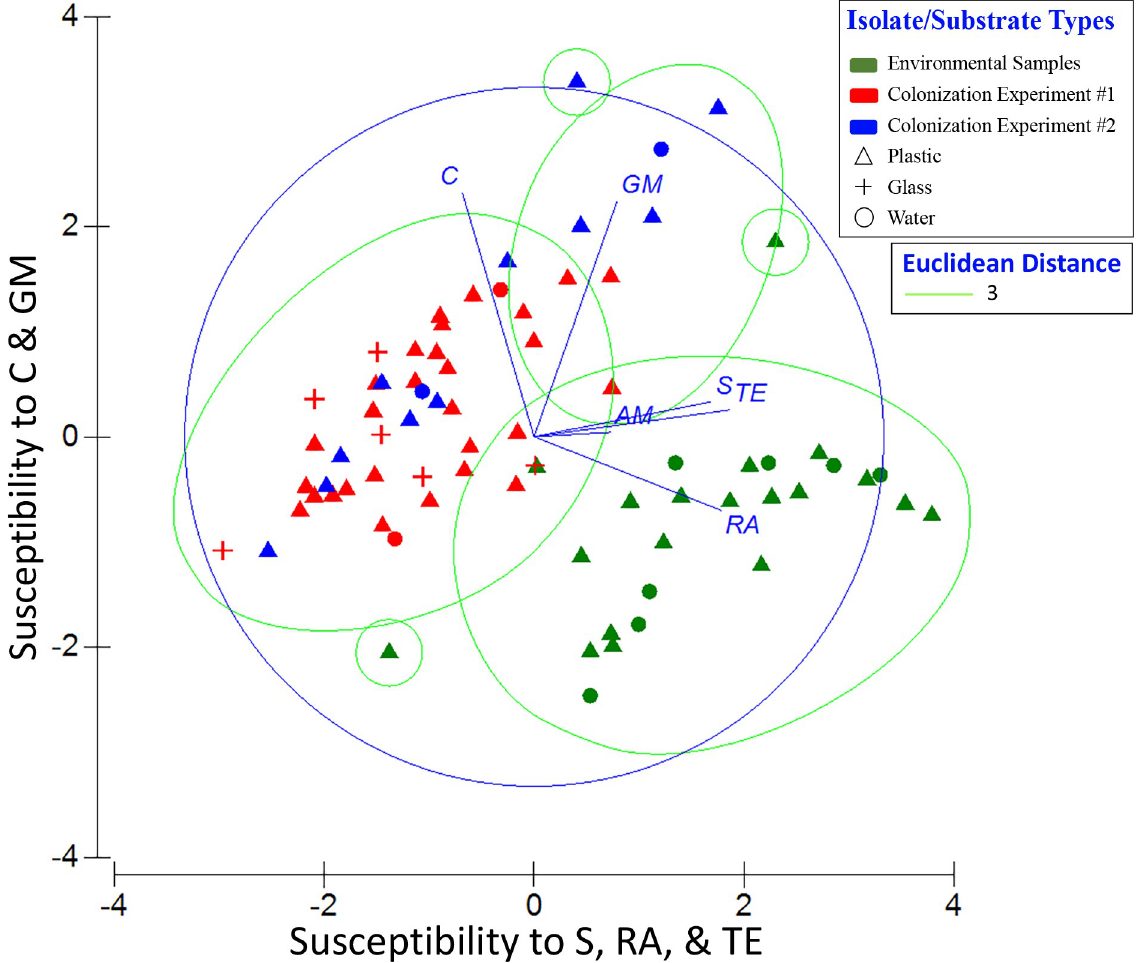
Fig 5. Principal components analysis (PCA) of antibiotic profiles of Vibrio spp. (n = 97) by sample type. PC1 represents increasing susceptibility to streptomycin (S), rifampin (RA), and tetracycline (TE), and PC2 represents increasing susceptibility to chloramphenicol (C) and gentamicin (GM). Eigenvectors for each antibiotic are shown as lines adjacent to the corresponding labels. Symbols as in Fig 4. The PCA is overlain with Euclidean distance (value of 3) from the cluster analysis (Fig